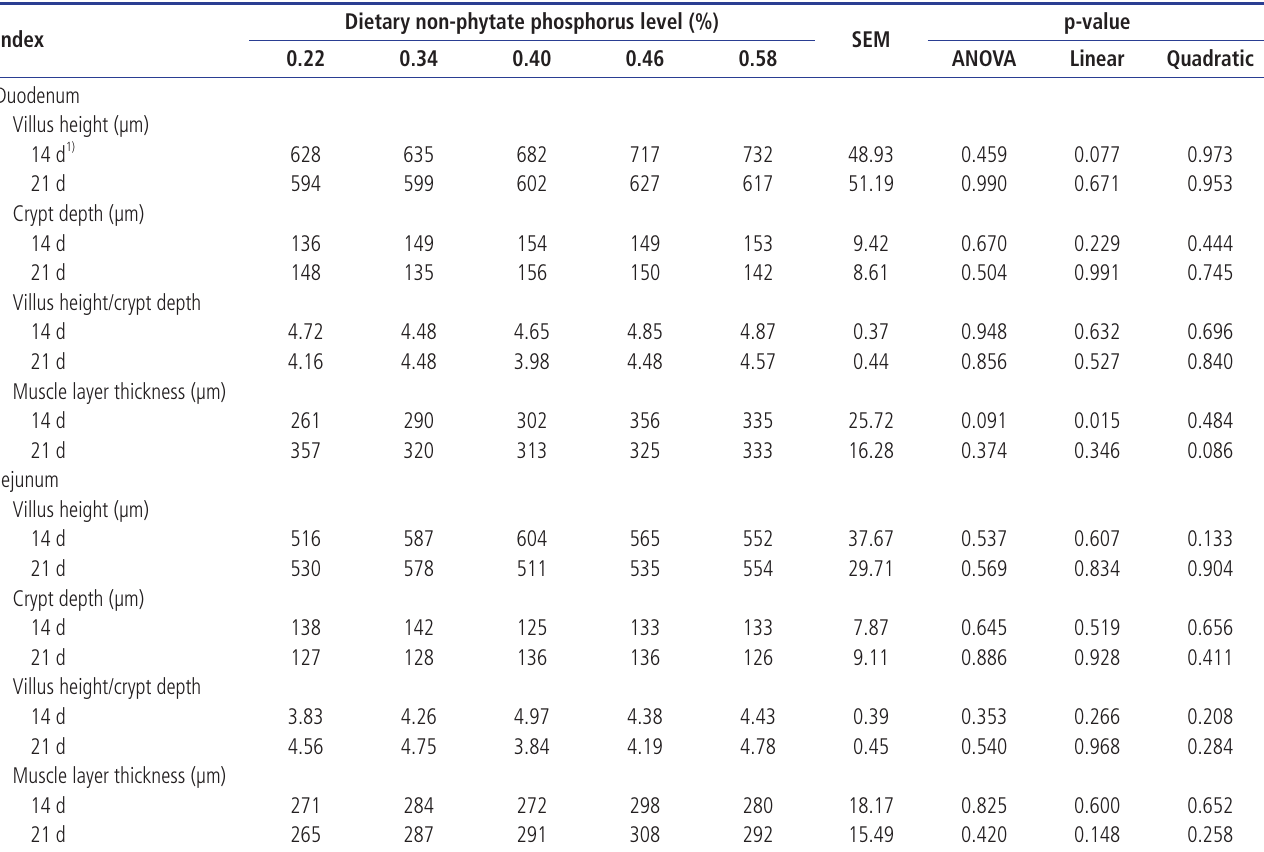
Table 6. Effect of dietary non-phytate phosphorus levels onintestinal morphology of ducks